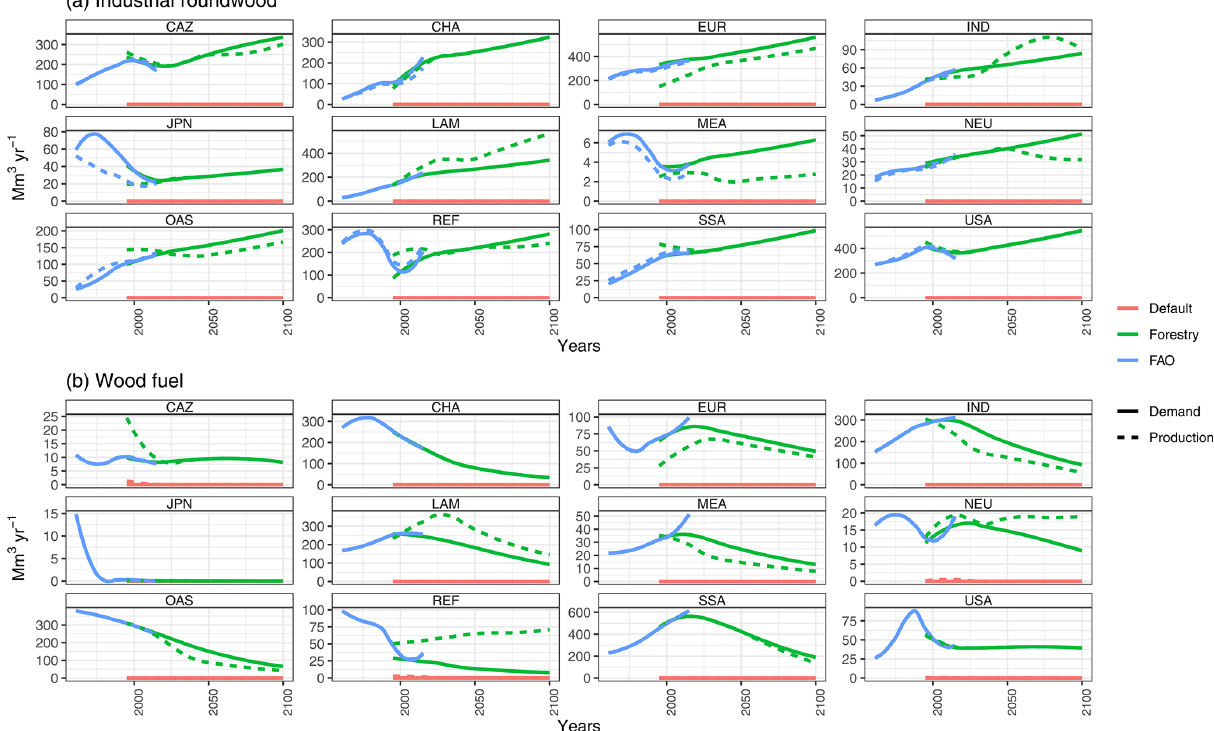
Figure A4. Production of and demand for industrial roundwood and wood fuel (in Mm 3 yr − 1 ).